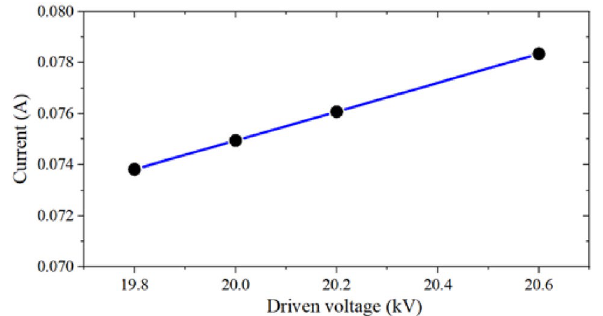
Figure 10. Influence of driven voltage fluctuations on beam current diagram.